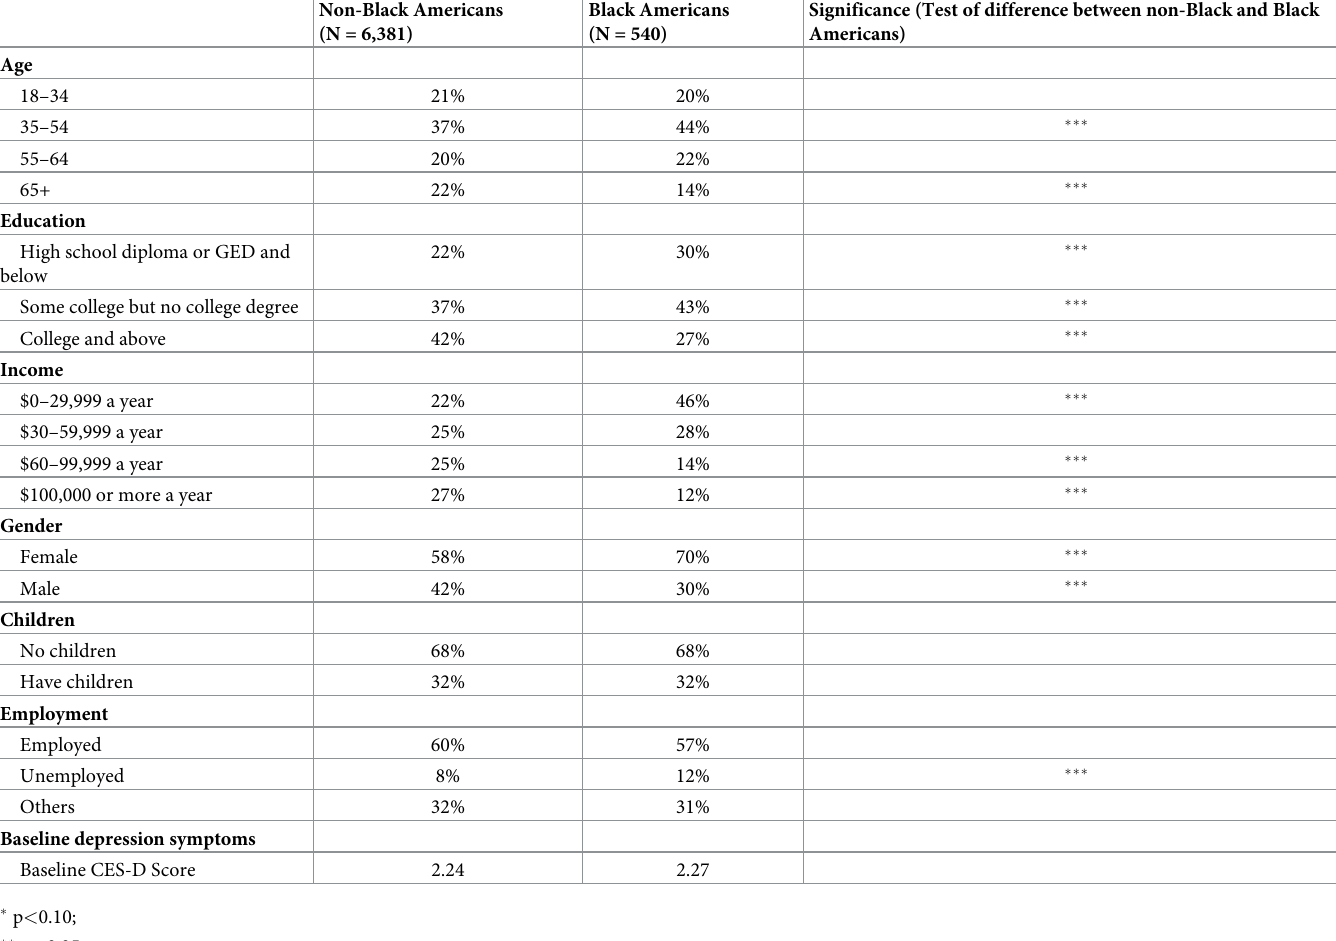
Table 2. Sample demographic composition, split by non-Black and Black vs. Americans.